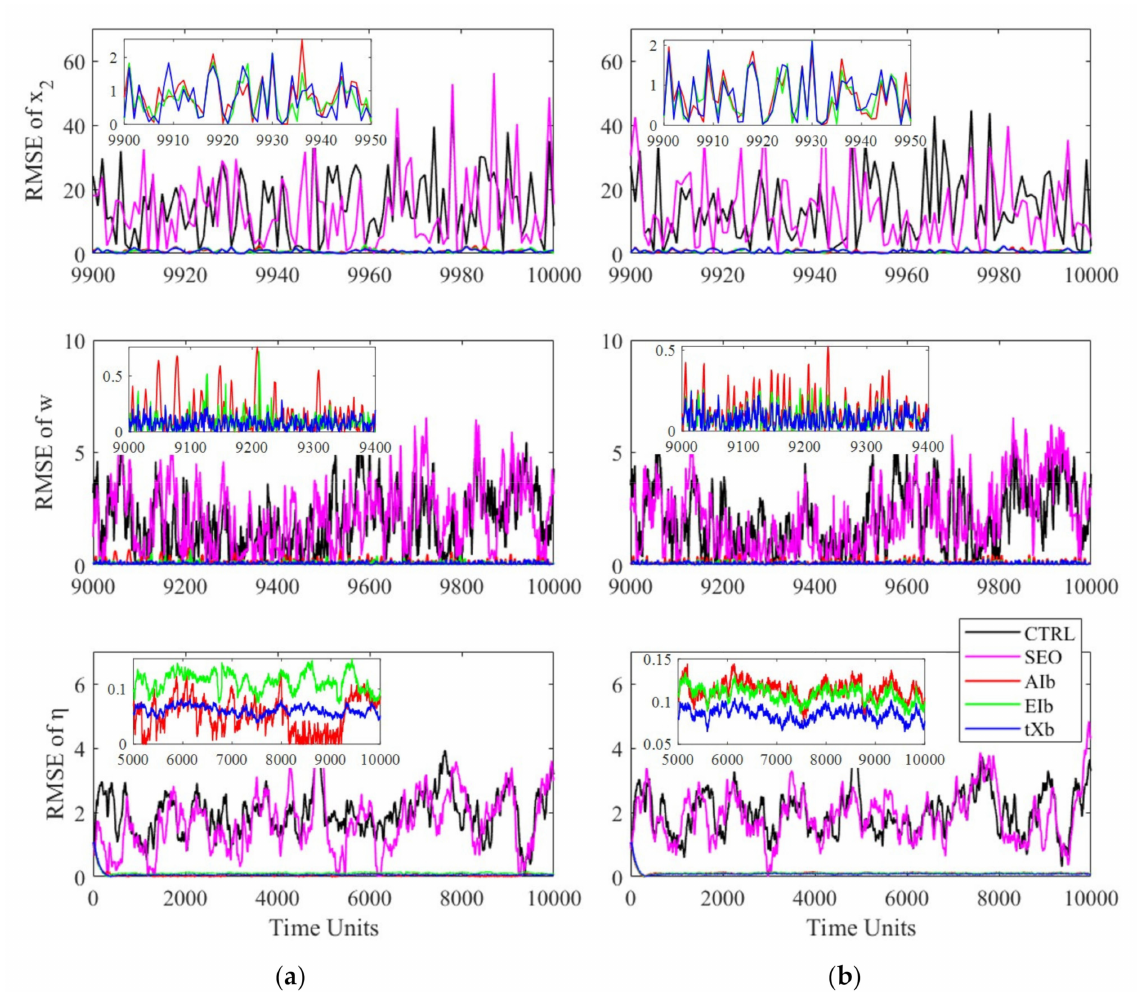
Figure 1. Time series of RMSEs of the atmospheric variable x 2 in the last 100 TUs, the upper-sea variable ω in the last 1000 TUs, and the deep-sea variable η in 10,000 TUs in the imperfect model with CTRL (black line), SEO (magenta line), AIb (red line), EIb (green line) and tXb (blue line), with an ensemble size of 5 for ( a ) and 20 for ( b ). The inset in each graph shows its partial enlargement to show the time series of RMSEs of x 2 in 50 TUs, ω in 400 TUs and η in the last 5000